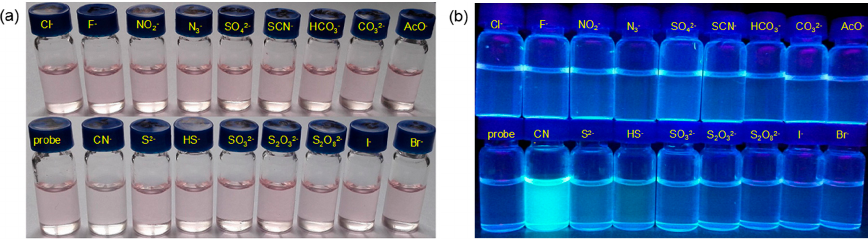
Figure 2. Fluorescence images of probe 1 (5 µM) upon addition of various anions (50 µM) in PBS/DMSO (4/6, pH = 7.4) solution under visible light ( a ); and 365 nm UV lamp ( b ).